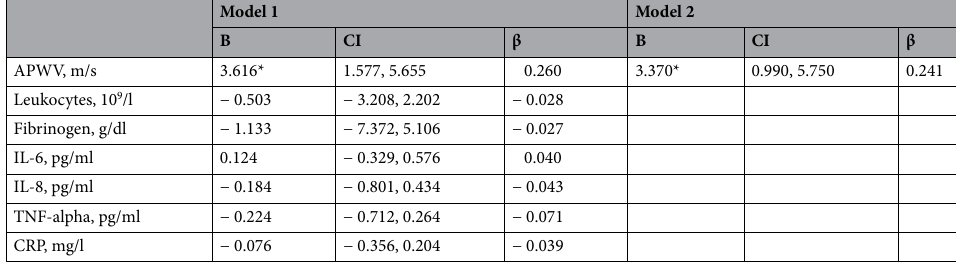
Table 3. Multiple regressions of cardiovascular and inflammatory markers on plasma HA in patients with COPD. Model 1; univariate model. Model 2; covariate adjusted (i.e. age, sex, LABA, ICS and combined ICS and LABA use). Abbreviations: APWV; arterial pulse wave velocity, B; unstandardized regression coefficient, β; standardized regression coefficient, CI; 95% confidence interval, CRP; c-reactive protein, ICS; inhaled corticosteroids, IL; interleukin, LABA; long-acting β2-agonists, TNF; tumor necrosis factor. * p ≤